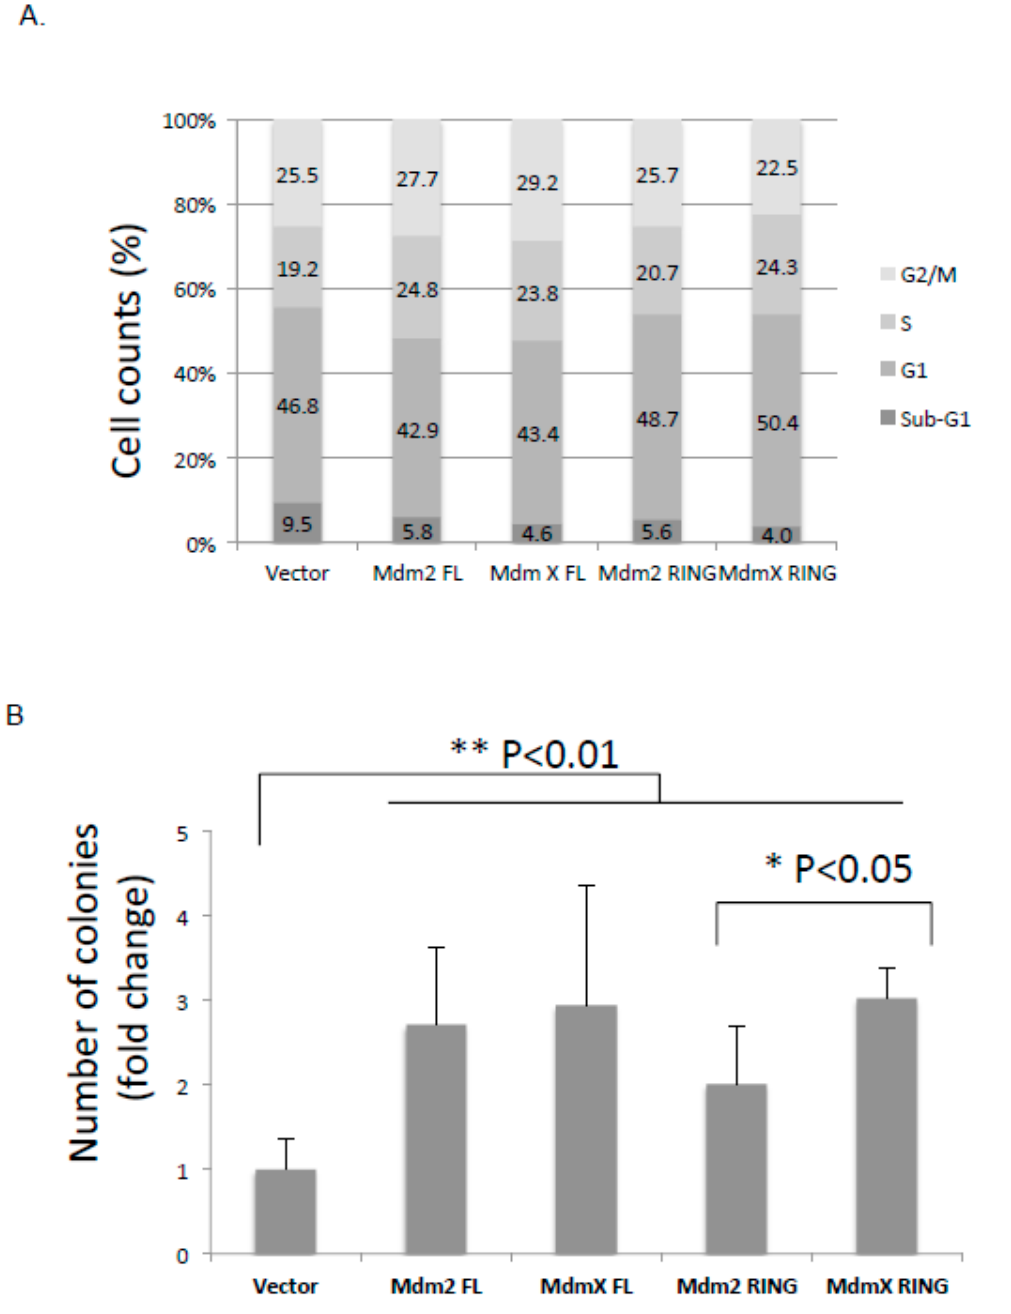
Figure 4. Effects of the ectopically expressed Mdm RING domains on cell cycle and colonogenic activity. ( A ) U2OS cells were transfected with FLAG vector or FLAG tagged-Mdm2, MdmX, Mdm2 RING, or MdmX RING. After a 24-hour transfection, cells were collected, stained with propidium iodide and analyzed for DNA content using flow cytometry. Percentage distribution of cells in each phase of cell cycle (sub-G1, G1, S, and G2/M) was indicated. ( B ) Equal number of U2OS cells were seeded after transfection with FLAG vector or FLAG tagged-Mdm2, MdmX, Mdm2 RING, or MdmX RING. Following a 10-day growing period, cells were washed twice and stained with methylene blue dye. Colonies were counted and normalized using vector as reference. The bar graph represents three independent experiments and results were analyzed using statistical one-way ANOVA test. * p ≤ 0.05; ** p ≤ 0.01.